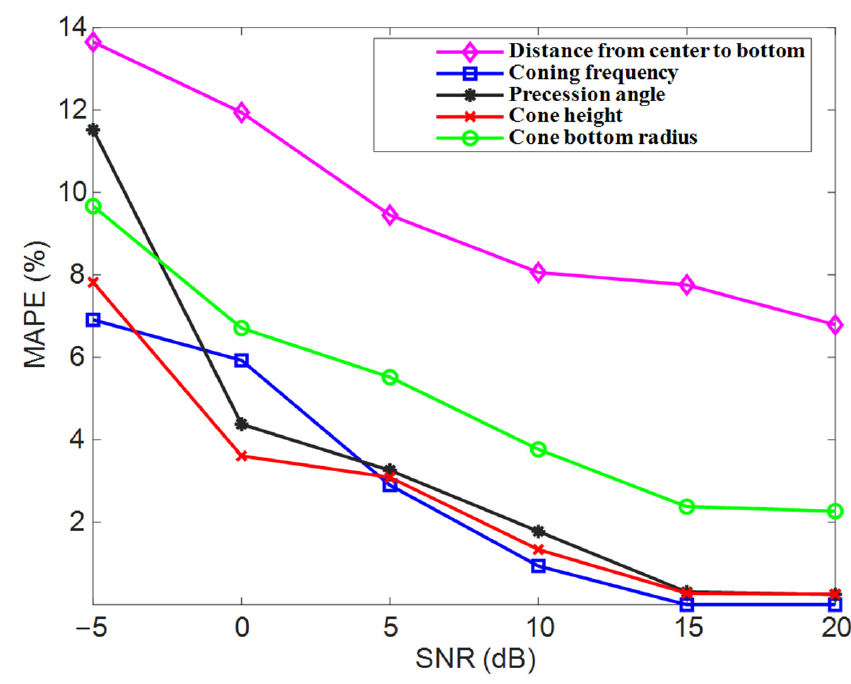
Figure 18. MAPE under different SNRs.